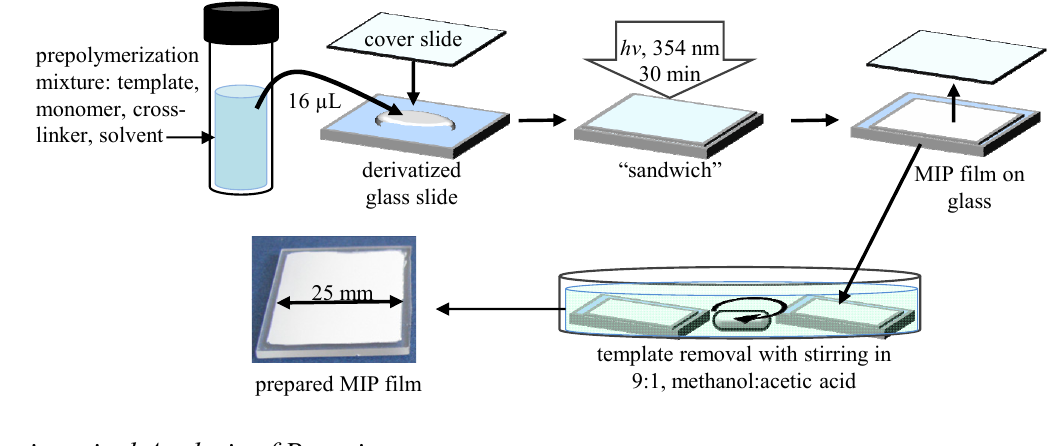
Figure 7. General scheme of fabrication of MIP films by “sandwich”